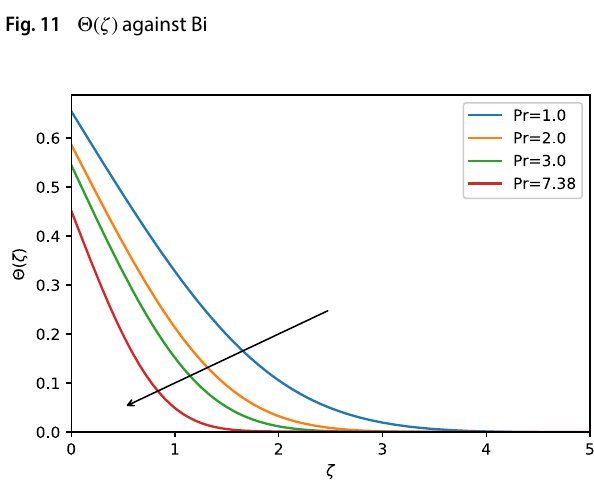
Fig. 8 Θ( 𝜁 ) against M